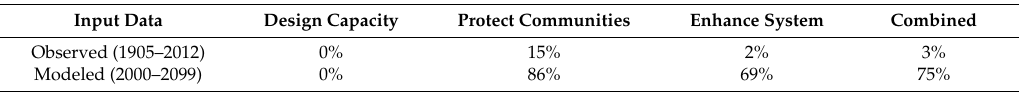
Table 5. BCR robustness indicator, percent of posterior draws of flood frequency parameters that yield a BCR above the